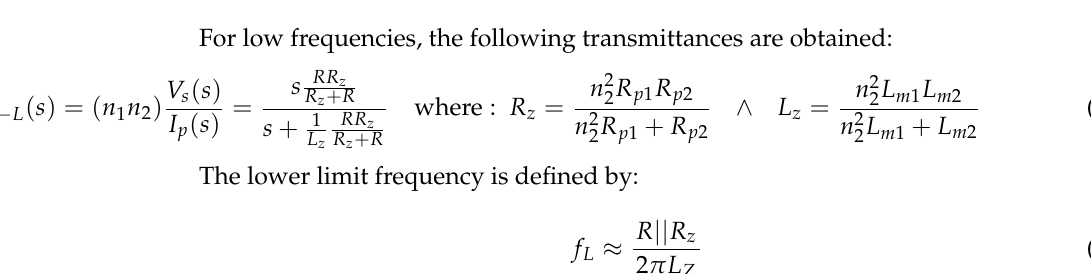
Figure 5. Proposed models of low-frequency cascaded connection of HFCTs.